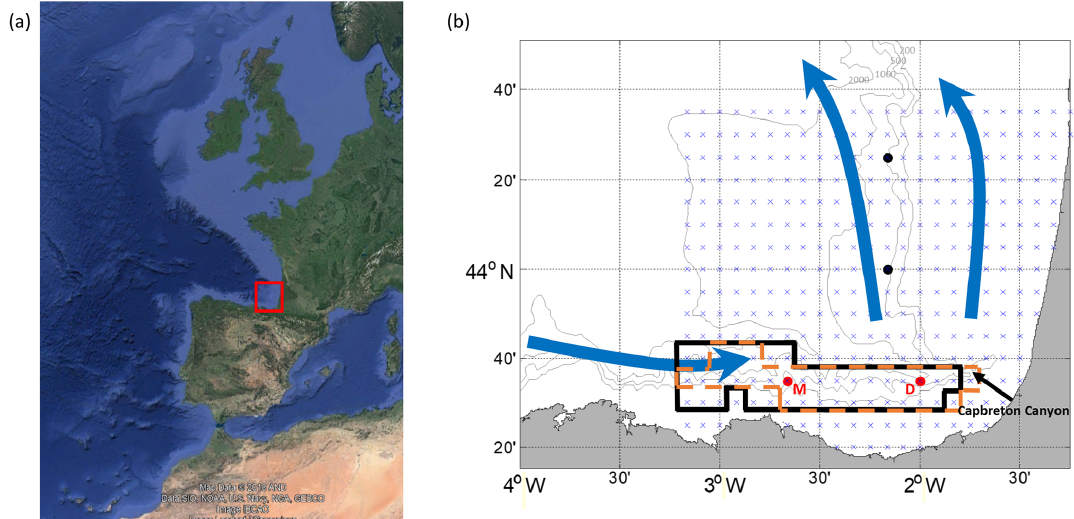
Figure 1. (a) Location of the study area (red square). Map data © 2018 AND Data SIO, NOAA, U.S. Navy, NGA, GEBCO. Image IBCAO. Image: Landsat/Copernicus. (b) Close-up map of the study area. The winter IPC is represented by solid blue arrows. The grid used for the emulated HFR surface current fields is shown by blue crosses. The red dots provide the locations of the current vertical profiles that emulate the EuskOOS moorings: Matxitxako (red M) and Donostia (red D), whereas the black dots depict the location of the two extra moorings used for the 4-mooring scenario. The bold black lines delimit the winter reduced grid, whereas the dashed orange lines delimit the summer one. The grey lines show the 200, 500, 1000 and 2000m